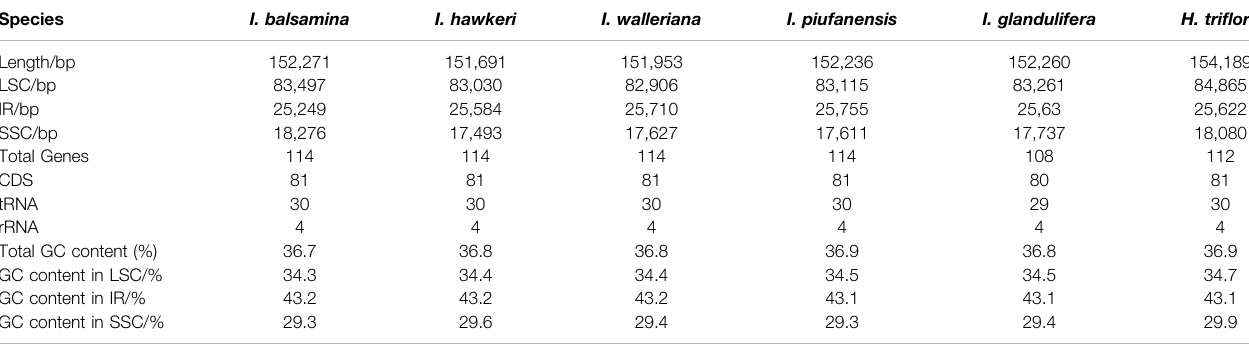
TABLE 2 | Characteristics of complete chloroplast genomes for Impatiens